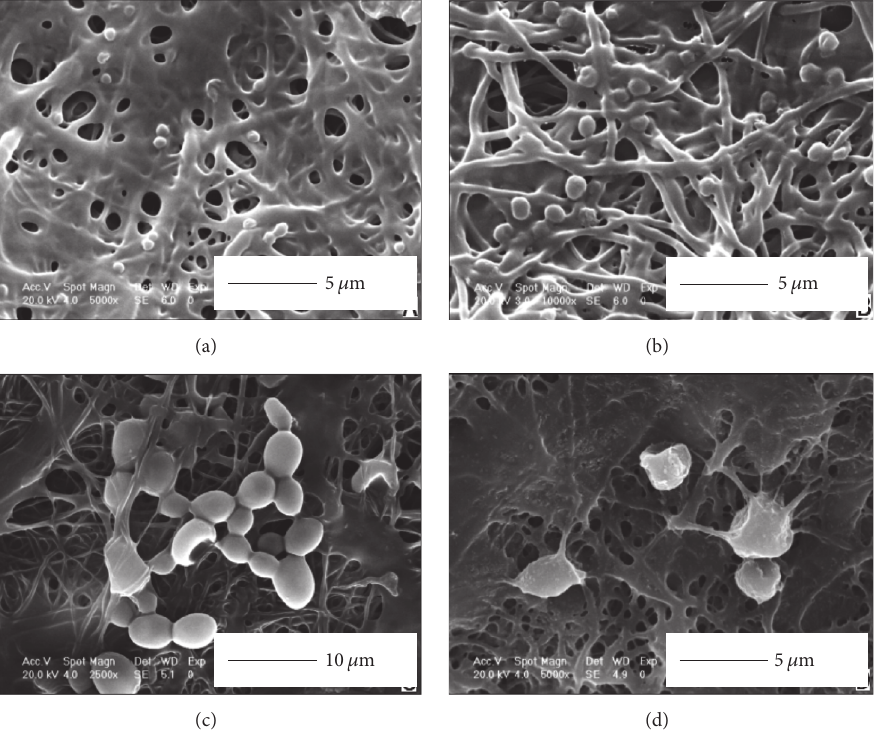
Figure 8: SEM images on morphology of cell adhesion to ZnO-3 for 12 hours. (a) S. aureus , (b) E. coli , (c) C. albicans , and (d) A. niger